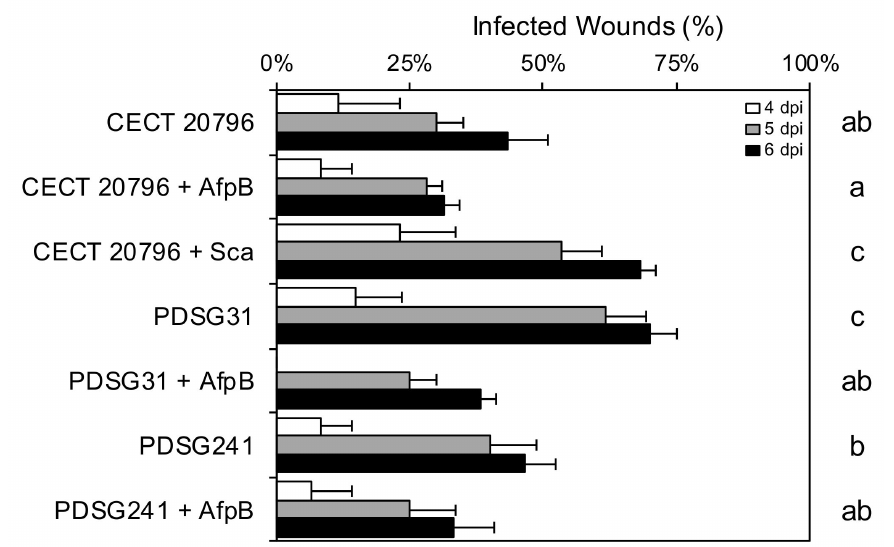
Figure 5. E ff ect of P. digitatum Sca and AfpB proteins on infection assays caused by di ff erent P. digitatum strains. Incidence of infection of wounds inoculated with 10 4 conidia / mL of di ff erent P. digitatum strains (parental CECT 20796, Sca op PDSG31 and ∆ sca PDSG241) alone or in the presence of 100 µ g / mL of AfpB or 180 µ g / mL of Sca. Data indicate the percentage of infected wounds (mean values ± SD of three replicates of five oranges) at each day post-inoculation (dpi). Di ff erent letters show statistical significance of the infection incidence compared to the control sample at 6 dpi (ANOVA and Tukey’s HSD, p <